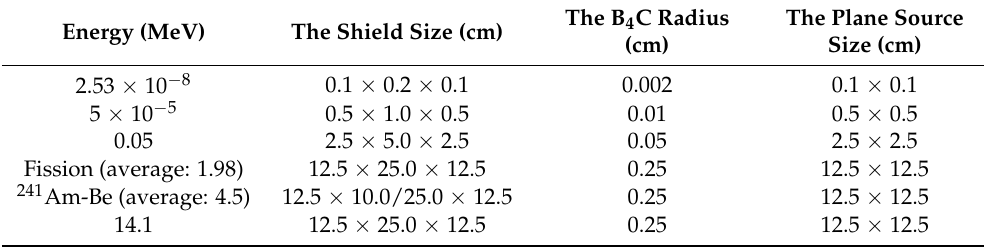
Table 3. The size of the shield, spherical B 4 C and the plane source. Energy